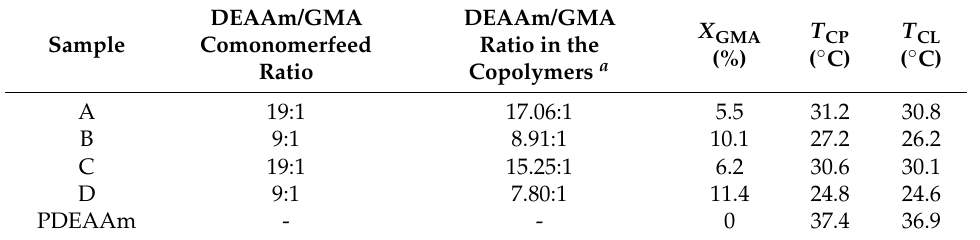
Figure 2. 1 H NMR spectra of the PDEAAm homopolymer ( A ) and the P(DEAAm- co -GMA) copoly- mer (Sample A, molar feed ratio AIBN:DEAAm:GMA = 1:95:5) ( B ). Table 2. The DEAAm/GMA molar ratios in the feed and in the P(DEAAm- co -GMA) copolymers, the molar percent of the GMA ( X GMA ) of the polymers and the cloud point ( T CP ) and clearing point ( T CL ) measured by